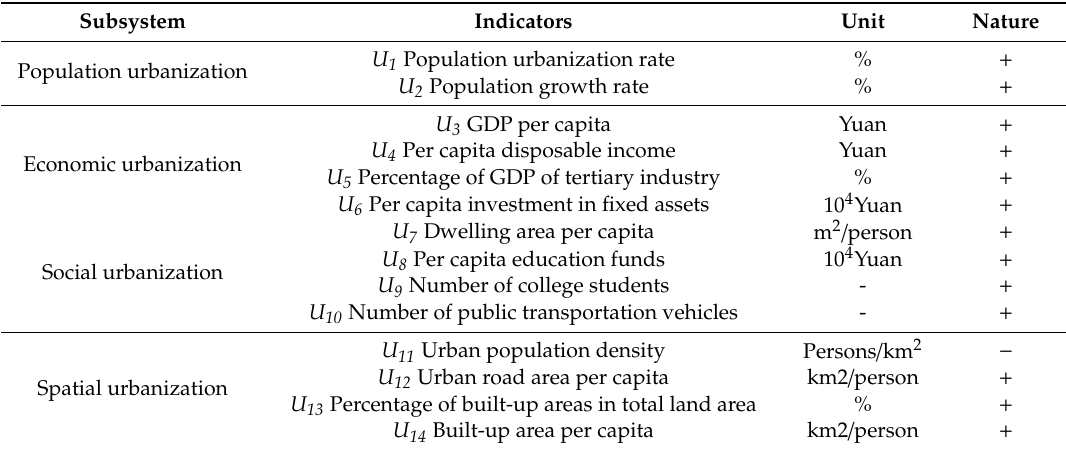
Table 1. Indicator system for the urbanization system.